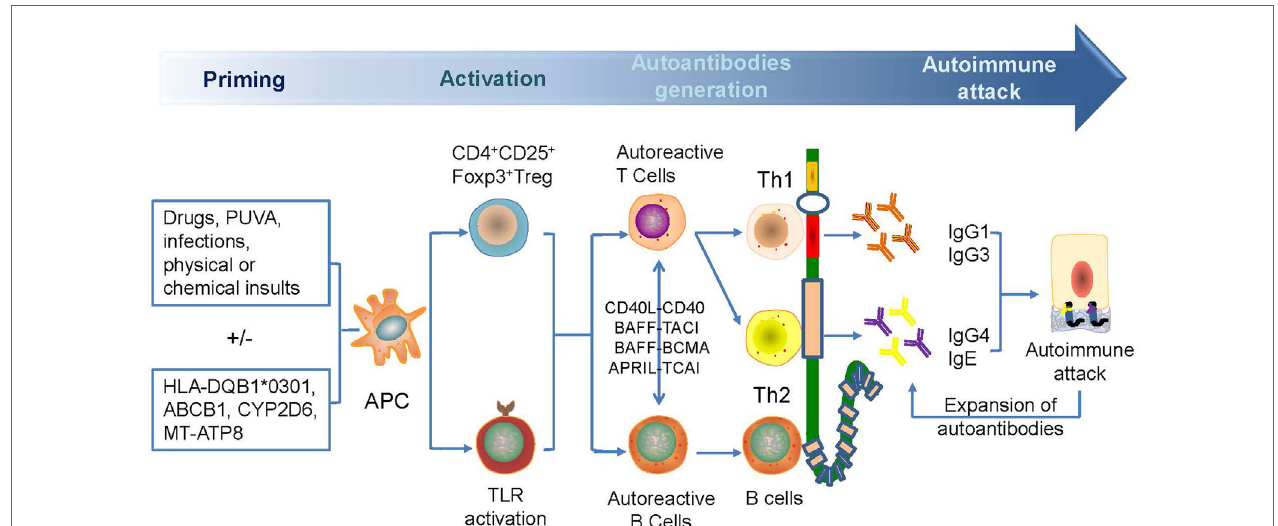
FigURe 2 | A possible mechanism for the generation of anti-BP180 autoantibodies. Antibodies are generated for the breakage of self-tolerance which is caused by drugs, psoralen, and ultraviolet A therapy, infections, physical, or chemical insults. Autoactivated Th1 and Th2 and B cell can target different domains of BP180, leading to the generation of anti-BP180 autoantibodies via epitope spreading and Ig class-switch. Such autoantibodies could be present in the serum for a long time before occurrence of clinical features. Attacked BP180 can be a source of new antigens to initiate the further expansion of autoantibodies and acceleration of